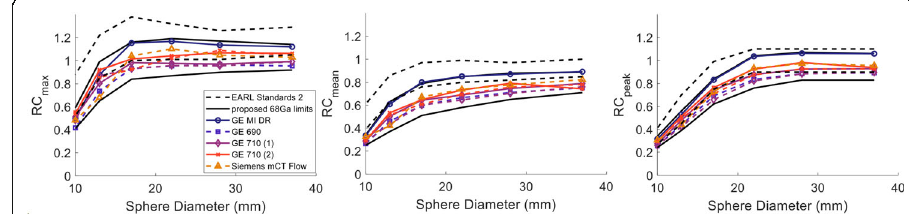
Fig. 6 RC max (left), RC mean (middle) and RC peak (right) for Gallium-68 from all five centres measured from the NEMA IQ phantom reconstructed with BPL 800 (solid lines) and PSF 6.4 for the GE scanners and PSF 5 for the Siemens scanner (dashed lines). The 2 RCs (dashed black lines) for the EARL 2 Fluorine-18 standards are also displayed as opposed to the limits proposed in this study for Gallium-68 (black solid